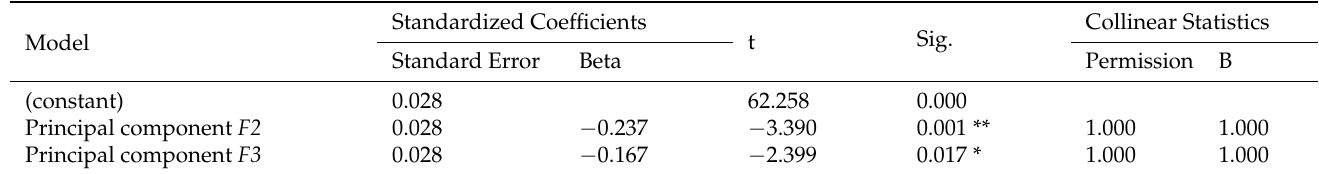
Table 12. Coefficient in the final model of the PRD